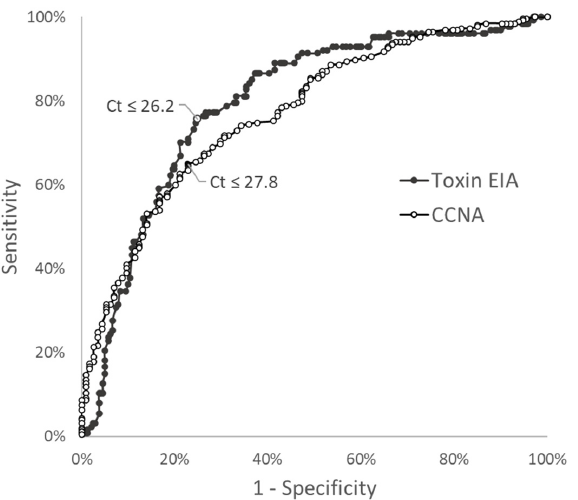
Figure 3. Receiver operating characteristic (ROC) curve for tcdB C t value predicting EIA toxin status (AUC = 0.795), or CCNA toxin status (AUC = 0.771). Youden cutoffs are indicated on each curve with their corresponding C t value cutoffs.